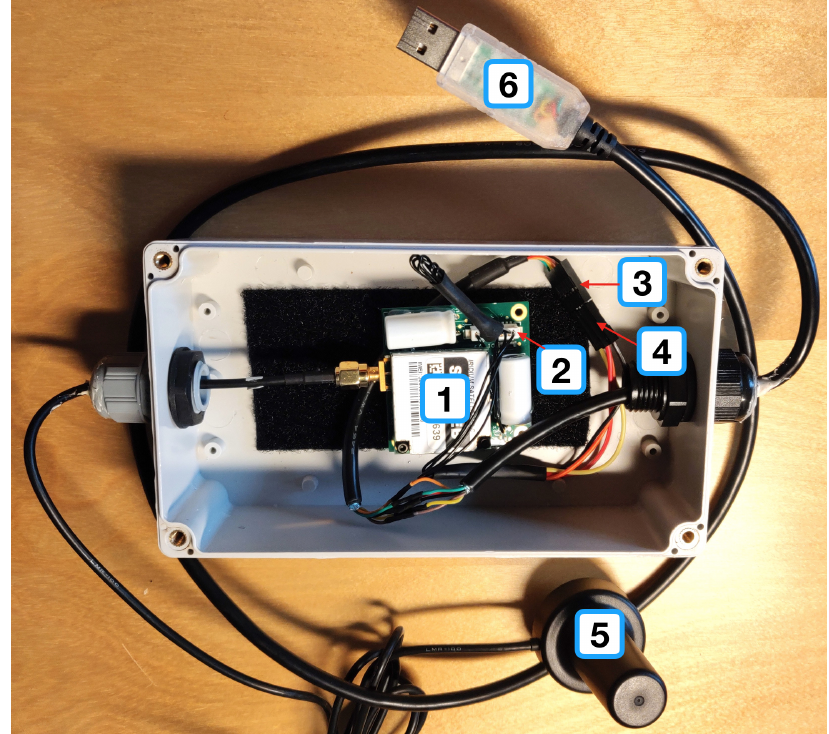
Figure A2. A RockBlock 9603 Iridium modem was housed in a PVC junction box (shown here with the lid removed) and was used to retrieve data in the field. The numbering corresponds to: 1. RockBlock 9603 Iridium modem; 2. Picoblade cable; 3. Female jumper cable; 4. Male jumper cables; 5; Maxtenna external SMA Iridium antenna; 6. FTDI serial TTL-232 USB